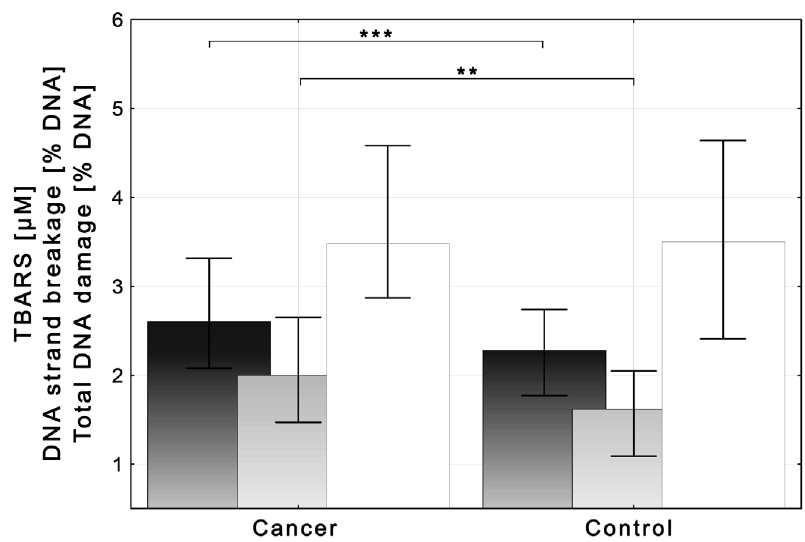
Figure 2. Levels of TBARS (dark columns), DNA strand breakage (grey columns) and total DNA damage (white columns) determined in whole blood samples from BrC cases and healthy control females. Data presented as medians (columns) and interquartile ranges (whiskers). Levels of TBARS among BrC cases (n=132) vs. control females (n=189): 2.6 [2.1–3.3] m M vs. 2.3 [1.8–2.7] m M, p , 0.0001, Mann-Whitney U test (***). Levels of DNA strand breakage and total DNA damage were assessed in the whole group of BrC cases and tested for differences against a subset of 40 control subjects randomly selected from the whole control group by means of the age-stratified randomization ( see Materials and Methods ). DNA strand breakage: BrC cases vs. controls: 2.0 [1.5–2.7] %DNA in comet tail vs. 1.6 [1.1–2.1] %DNA in comet tail, p , 0.001, Mann-Whitney U test (**). Total DNA damage: BrC cases vs. controls: 3.5 [2.9–4.6] %DNA in comet tail vs. 3.5 [2.4–4.6] %DNA in comet tail, NS . The age distribution in the control subset was verified to match with the one in the whole control group ( see Table 1 ). The distribution of TBARS in the randomized subset of 40 controls did not differ significantly from the one observed in the whole control group (1.7 [1.5–2.1] m M vs. 2.3 [1.8–2.7] m M, NS ) but differed significantly from the one in the BrC group (1.7 [1.5–2.1] m M vs. 2.6 [2.1–3.3] m M, p , 0.001, Kruskal-Wallis H -test post-hoc